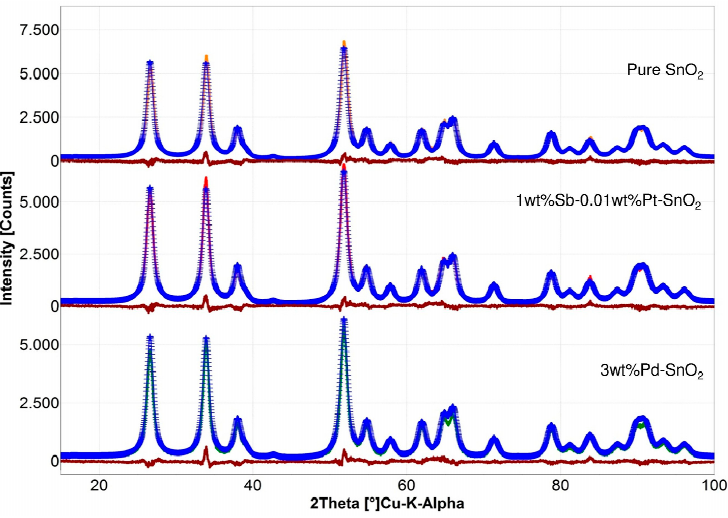
Figure 1. The Rietveld analysis of the XRD patterns of pure SnO 2 (upper panel), 1 wt % Sb–0.01 wt % Pt-SnO 2 //3 wt % Pd-SnO 2 (middle panel) and 3 wt % Pd-SnO 2 (lower panel).